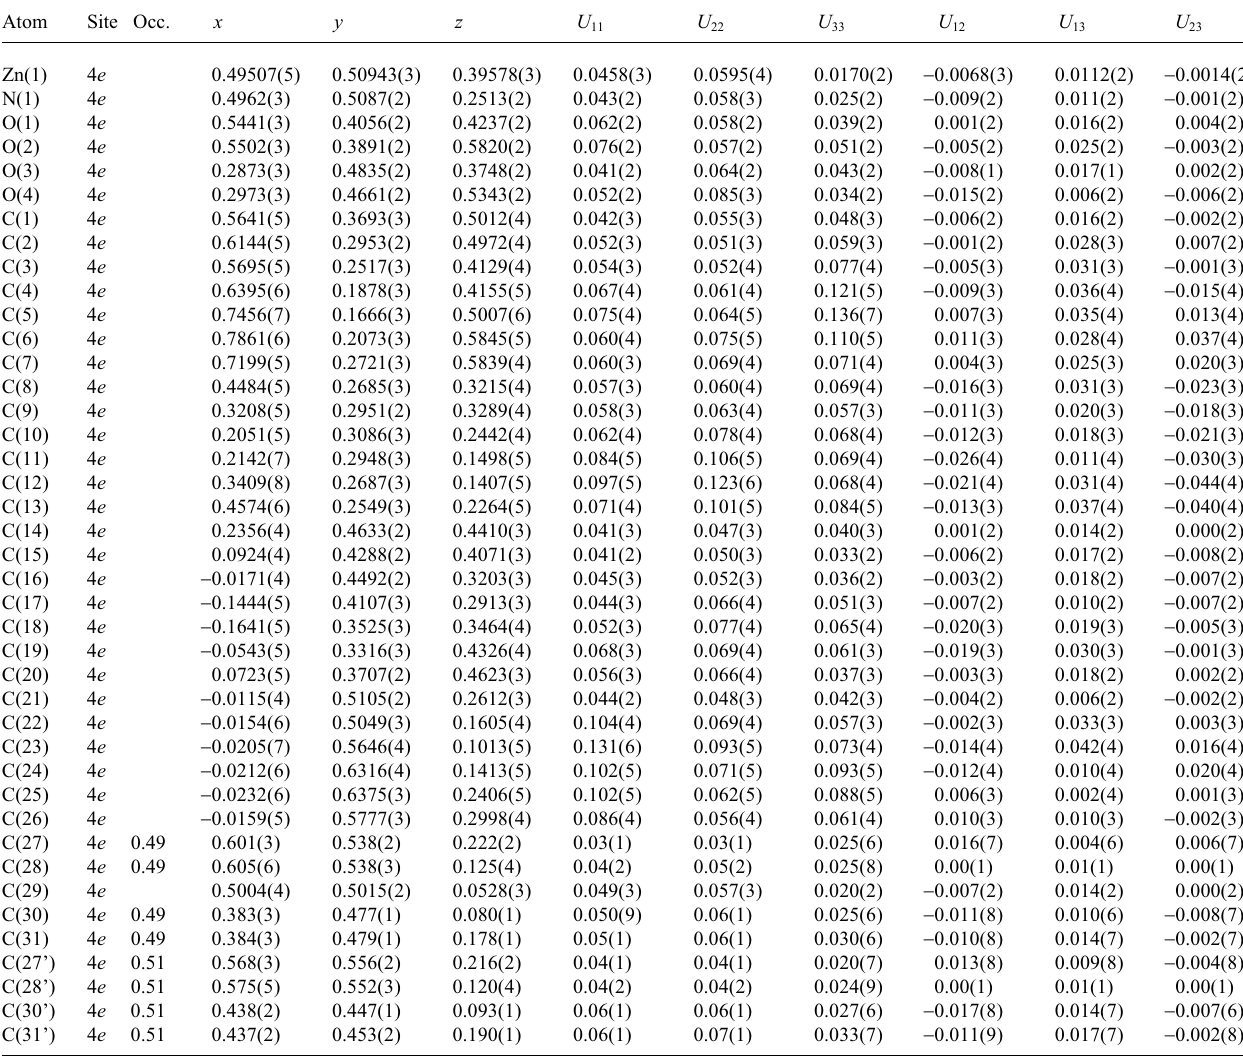
Table 3. Atomic coordinates and displacement parameters (in Å 2 ) . Atom Site